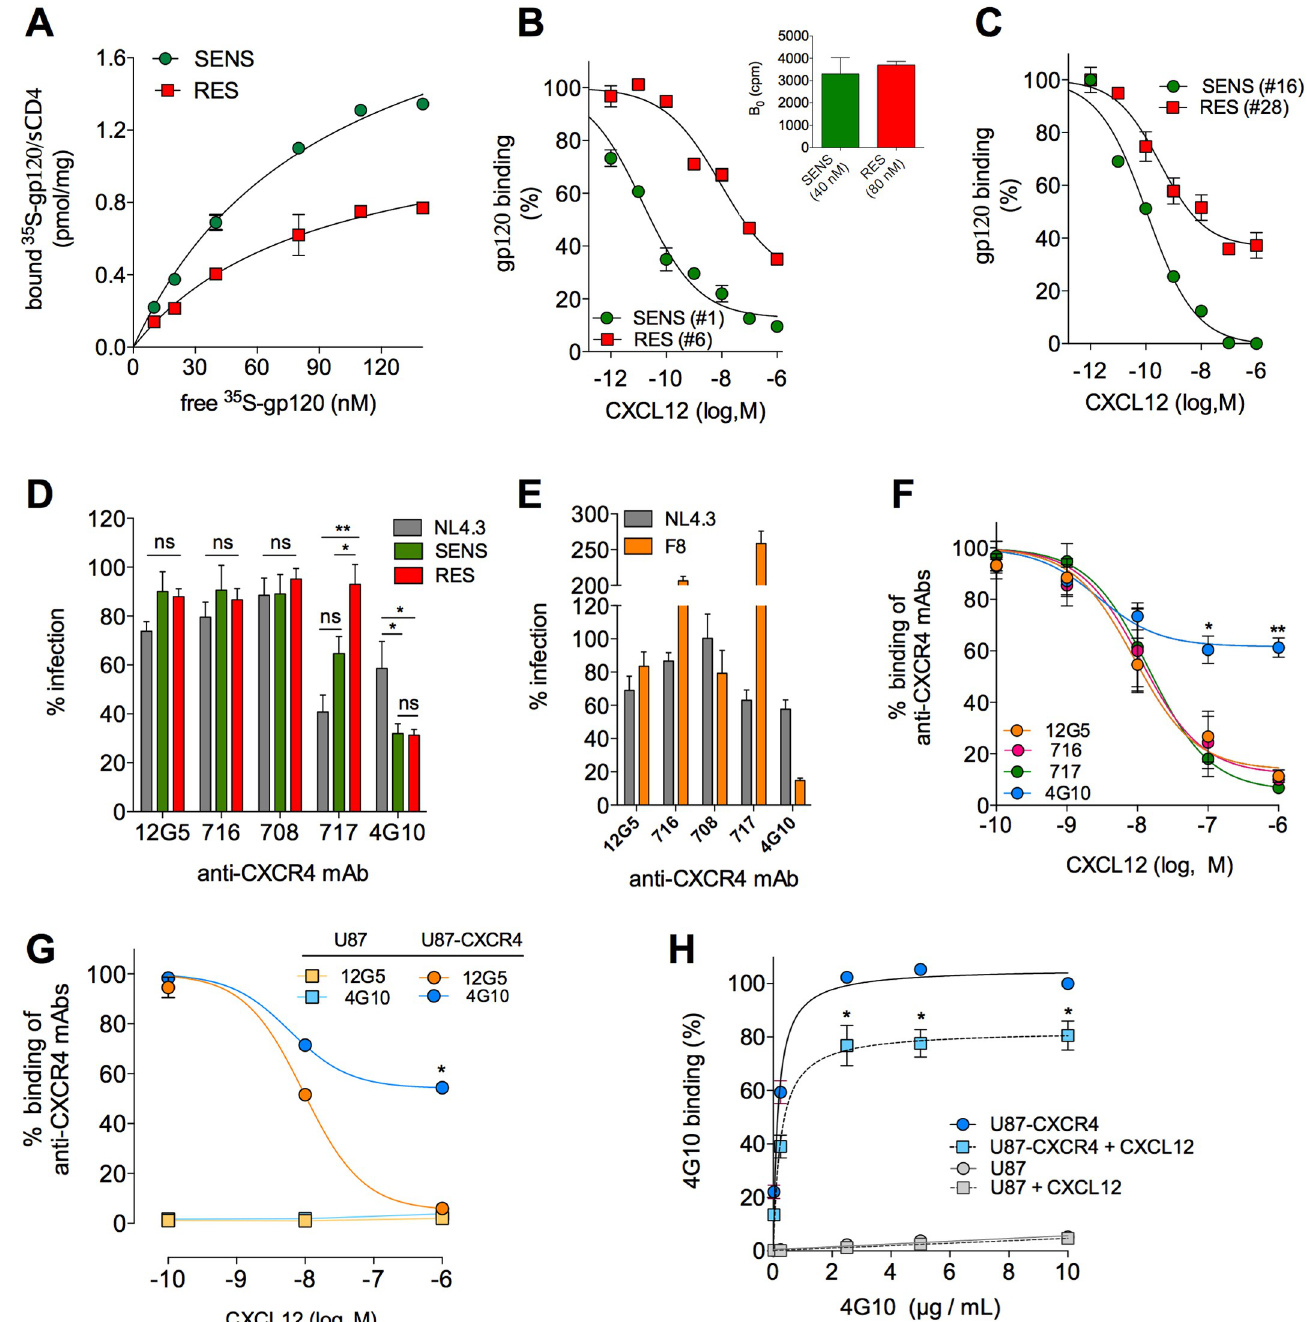
Fig 4. CXCL12-resistant viruses interact with CXCR4 molecules that are weakly accessible to the chemokine. A Specific binding (SB) of gp120/sCD4 complexes to PBMC membranes. A representative experiment with gp120s #1 (SENS) and #6 (RES) (P#39) is shown. Gp120 #16 (SENS) and #28 (RES) (P#208) gave similar results. The extrapolated B max (i.e. maximum level of binding) were 2.9 and 1.6 pmole/mg for SENS and RES gp120s, respectively. B and C Displacement of gp120 binding by CXCL12. Forty and 80 nM of SENS or RES gp120/sCD4, respectively, were used, leading to similar levels of SB in the absence of CXCL12 (inset). D Effects of anti-CXCR4 mAbs on infection of CD4TL with SENS and RES viruses, expressed as percent infection relative to untreated control (100%). Means ± SEM of 5 independent experiments are shown, carried out with 20 ng of p24 of the viruses pseudotyped with Envs # 1 (SENS), # 6 (RES), # 16 (SENS), # 28 (RES) or NL4-3 Env. E Effects of anti-CXCR4 mAbs on virus population F8. Ten μ M MVC was added to the assay medium. F Displacement of binding of anti-CXCR4 mAbs to CD4TL by CXCL12. Results (means ± SEM) are expressed relative to binding in the absence of CXCL12 (100%). The competition curves gave Ki values for CXCL12 ranging between 2.6 and 8.7 nM. G Displacement of binding of mAbs 4G10 and 12G5 to U87-CXCR4 cells by CXCL12. H Specific binding of 4G10 to U87-CXCR4 cells in the presence or absence of 1 μ M CXCL12. Non-specific binding on parental U87 cells is also shown (grey